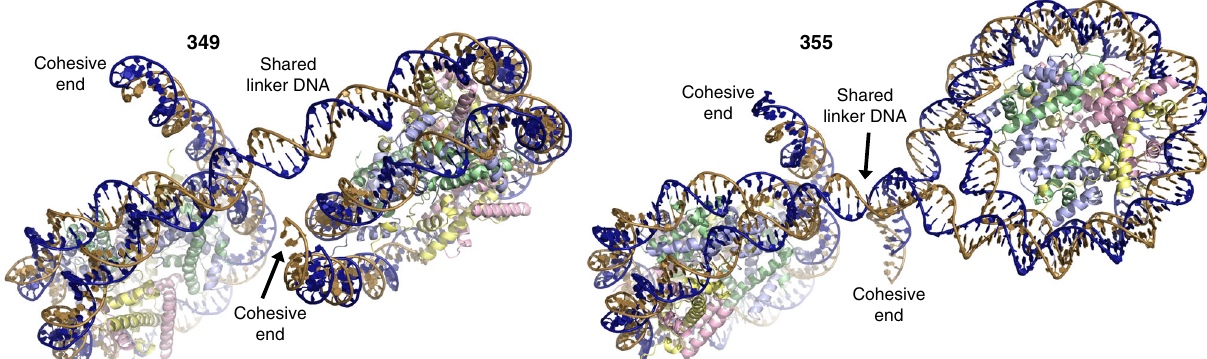
Fig. 1 Dinucleosome constructs that assemble into fi bres. DNA sequences (single strand, 5 ′ – 3 ′ direction) and structures for the 349 and 355 dinucleosomes are shown. Above, the base pairs at the nucleosome centres (dyads) are highlighted in bold, base pair insertions of 355 relative to 349 are underlined and the bars designate the midpoints of pairing of the GTAC cohesive ends between dinucleosomes in the fi bre. Below, the dinucleosome structures correspond to the repeating (asymmetric) units in the fi bres. The two DNA strands are coloured blue and gold, and the core histone proteins are pale yellow (H2A), pink (H2B), purple (H3) and green